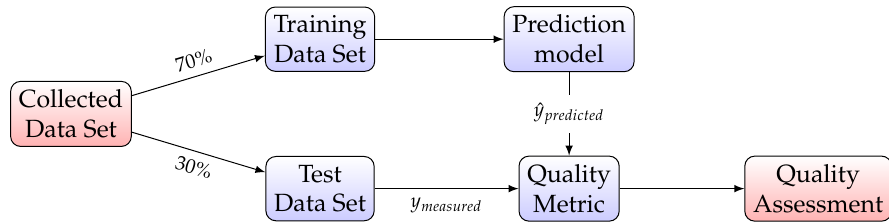
Figure 20. Assessing the performance of machine learning to build a predictive